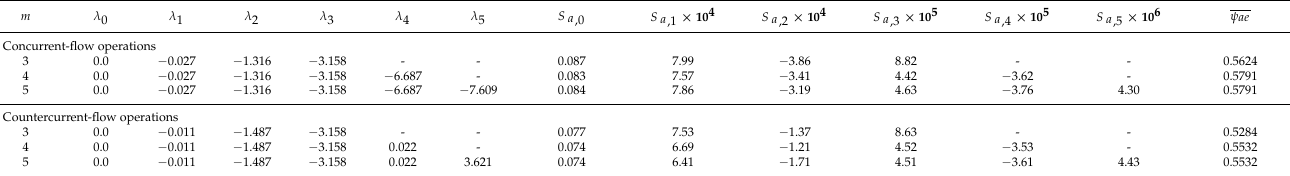
The orthogonality condition used in the concentric circular membrane contactor system of the case λ m (cid:54) = λ n is verified, to solve for coefficients S a , m and S b , m as